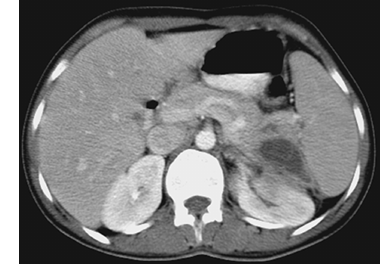
Figure 11. Thoracic computed tomography (A) scan showing intramedullary lytic and enlarging masses posterior to the fourth, fifth, and sixth ribs on the right. A hydatid cyst is seen in the right latissumus dorsi muscle on the T1- and T2-weighted thorax magnetic resonance image (MRI) (B) of the same patient. Demonstration of cysts in the same patient on coronal T2-weighted thorax MRI (C).